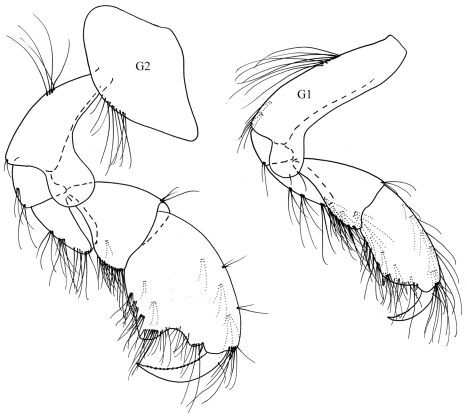
Paragrubia edgariHughes & Lowry, male